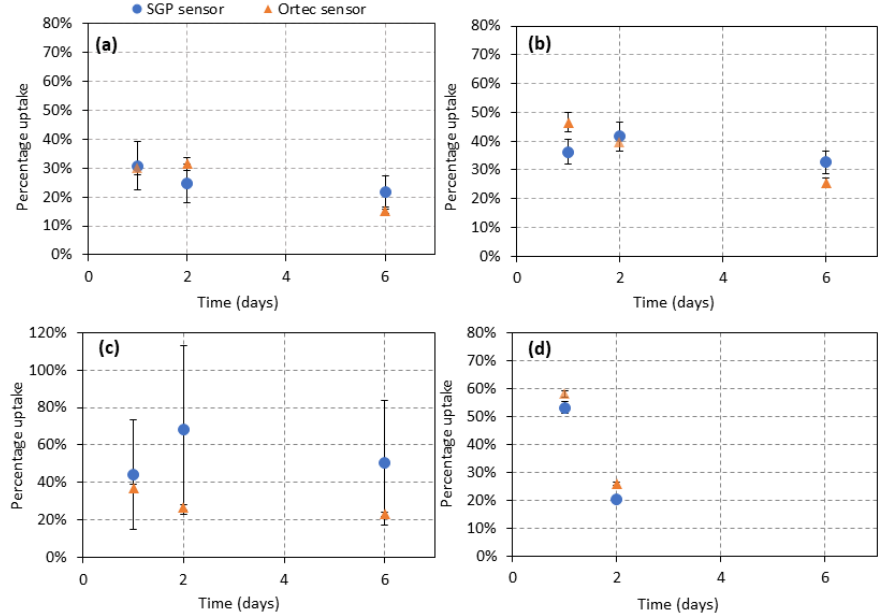
Figure 3. Group A RIU values of as a function of time (days), for ( a ) Patient 1, ( b ) Patient 2, ( c ) Patient 3 and ( d ) Patient 4. The error bars on all data points represent the standard deviation of two independent measurements.